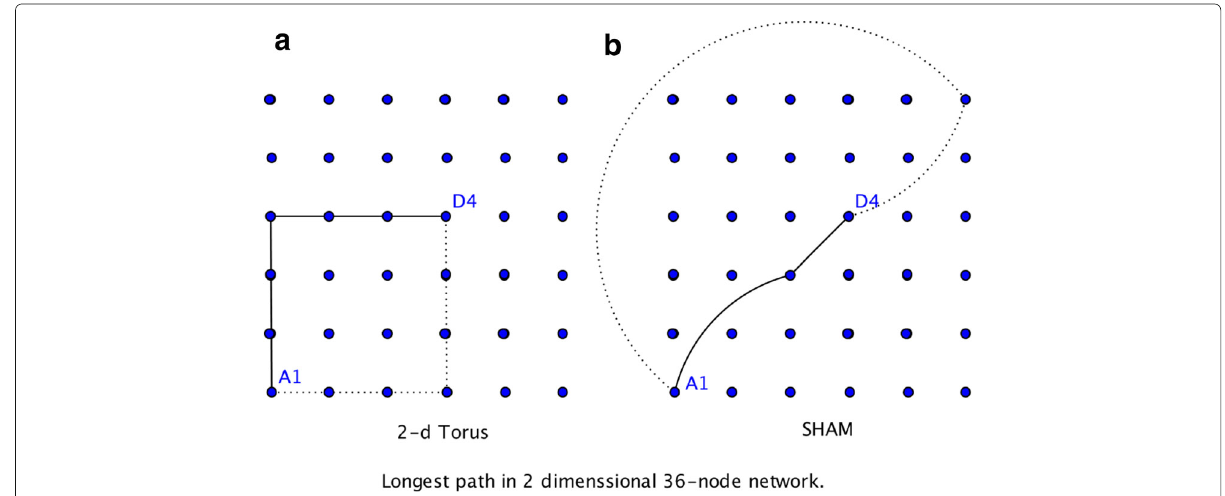
Fig. 8 Depiction of routing in SHAM vs. Torus. a In 2-d torus: the longest path is between nodes A1 and D4. It requires the lookup six hops to reach D4 from A1 (solid line). Another possible same length route is the dashed line. b In case of SHAM: the longest path is also between A1 and D4. It requires the lookup two hops to reach D4 (solid line). Another same length route is the dashed